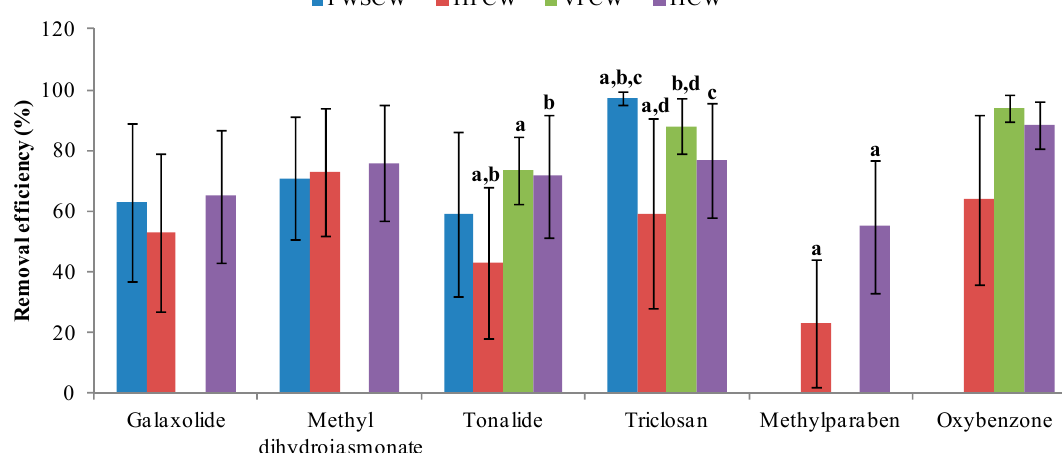
Figure 4. Removal e ffi ciency of six selected PCPs with di ff erent types of CWs. Note: Tonalide: ‘a’ Figure 4. Removal efficiency of six selected PCPs with different types of CWs. Note: To- shows that horizontal flow constructed wetlands (HFCW) exhibit significant di ff erence from vertical nalide: ‘a’ shows that horizontal flow constructed wetlands (HFCW) exhibit significant dif- flow constructed wetlands (VFCW); ‘b’ shows that HFCW and hybrid constructed wetlands (HCW) ference from vertical flow constructed wetlands (VFCW); ‘b’ shows that HFCW and hybrid are significantly di ff erent from each other; Triclosan: ‘a’ shows that free water surface constructed constructed wetlands (HCW) are significantly different from each other; Triclosan: ‘a’ wetlands (FWSCW) exhibit significant di ff erence from HFCW; ‘b’ shows that FWSCW and VFCW are shows that free water surface constructed wetlands (FWSCW) exhibit significant difference significantly di ff erent from each other; ‘c’ shows that FWSCW exhibit significant di ff erence from HCW; from HFCW; ‘b’ shows that FWSCW and VFCW are significantly different from each other; ‘d’ shows that HFCW and VFCW are significantly di ff erent from each other; Methylparaben: ‘a’ shows ‘c’ shows that FWSCW exhibit significant difference from HCW; ‘d’ shows that HFCW and that HFCW exhibit significant di ff erence from HCW at α = 0.05 ( p < 0.05); The number of observations VFCW are significantly different from each other; Methylparaben: ‘a’ shows that HFCW for studied PCPs in di ff erent types of CWs is given in Table S10 (Supplementary exhibit significant difference from HCW at α = 0.05 ( p < 0.05); The number of observations for studied PCPs in different types of CWs is given in Table S10 (Supplementary Materials).